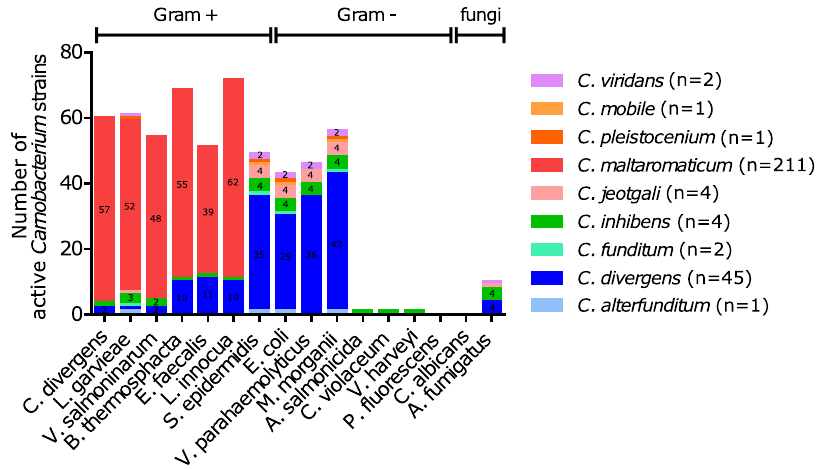
Figure 5. The number of active Carnobacterium spp. strains according to the species. Carnobacterium spp. strain cultures were spotted on agar plates inoculated with one of the indicator strains. A strain was considered active when the presence of an inhibitory halo could be observed. The number of active strains was indicated inside the bar for species represented by more than one strain. n: total number of Carnobacterium spp. strains tested per species.